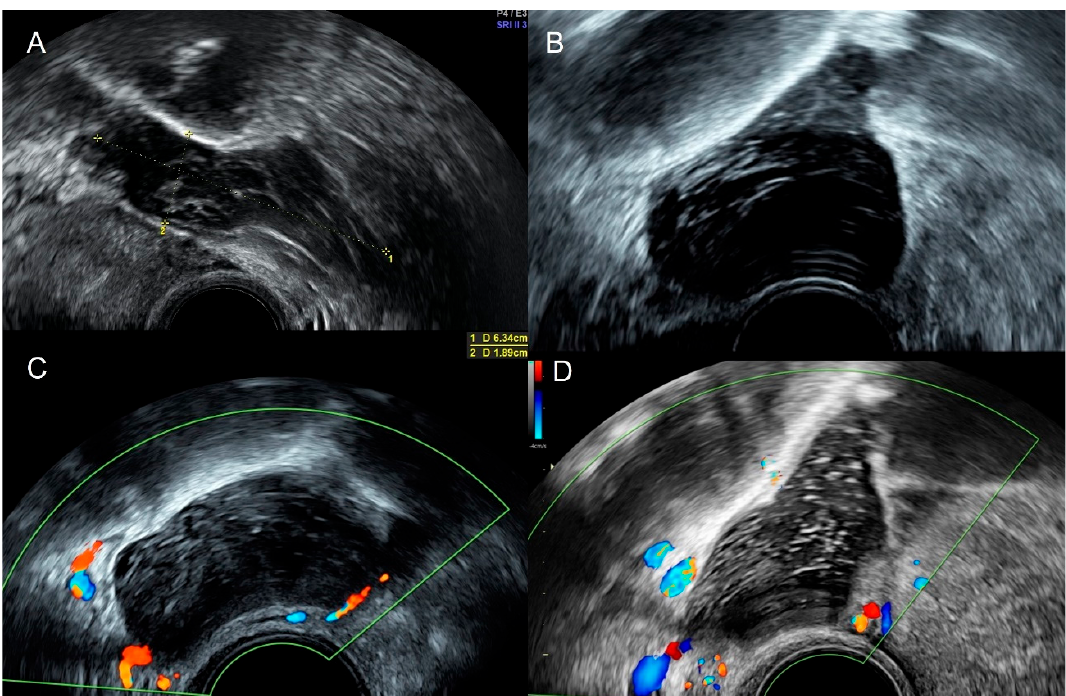
Figure 26. Transvaginal ultrasound shows Tarlov cyst as a well-defined cystic lesion in the adnexal region with the presence of some echoes or a network of very fine walls inside it ( A – D ).